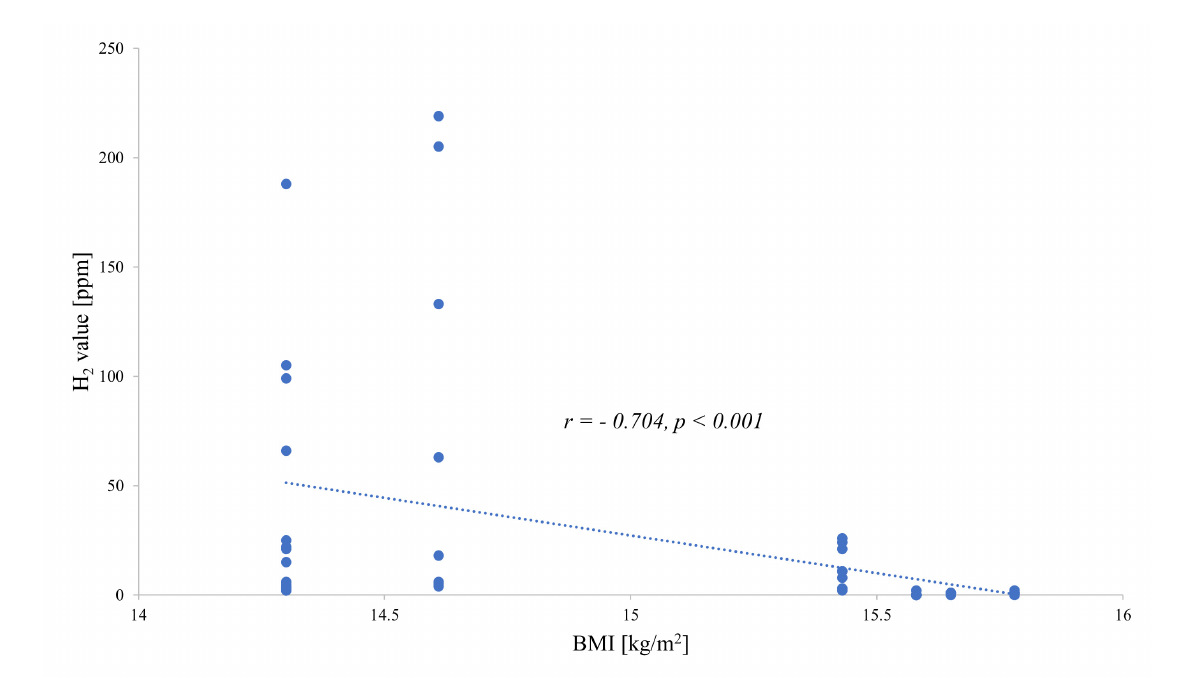
FIGURE2 Correlation between end-expiratory hydrogen values during the lactose breath test and body mass index.